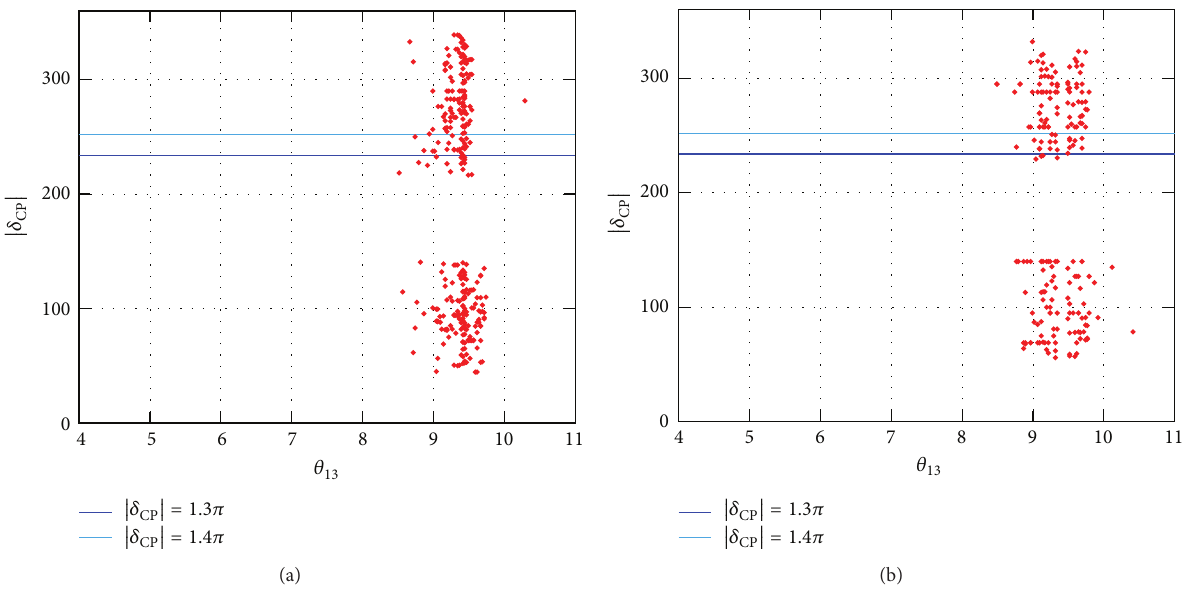
Figure 3: Allowed region constrained by the present BAU bounds, 5.7 × 10 −10 < 𝜂 𝐵 < 6.7 × 10 −10 for 𝛿 , 𝜃 13 for the case when 𝑅 matrix CP and 𝑈 . The regions are obtained by varying 𝛿 range at ≥ 2 𝜎 over the corresponding 𝜒 2 minima distribution from consists of both 𝑉 CKM PMNS CP Figure 2 and 𝜃 13 with its experimental values varied within 3𝜎 . In Figure (a) (Figure (b)) we show the plot for the IH and LO case (IH and = 1.3𝜋 (1.4𝜋) around which the best fit values of CPV phase 𝛿 are assumed to HO case). The blue (cyan) horizontal line represents 𝛿 CP CP